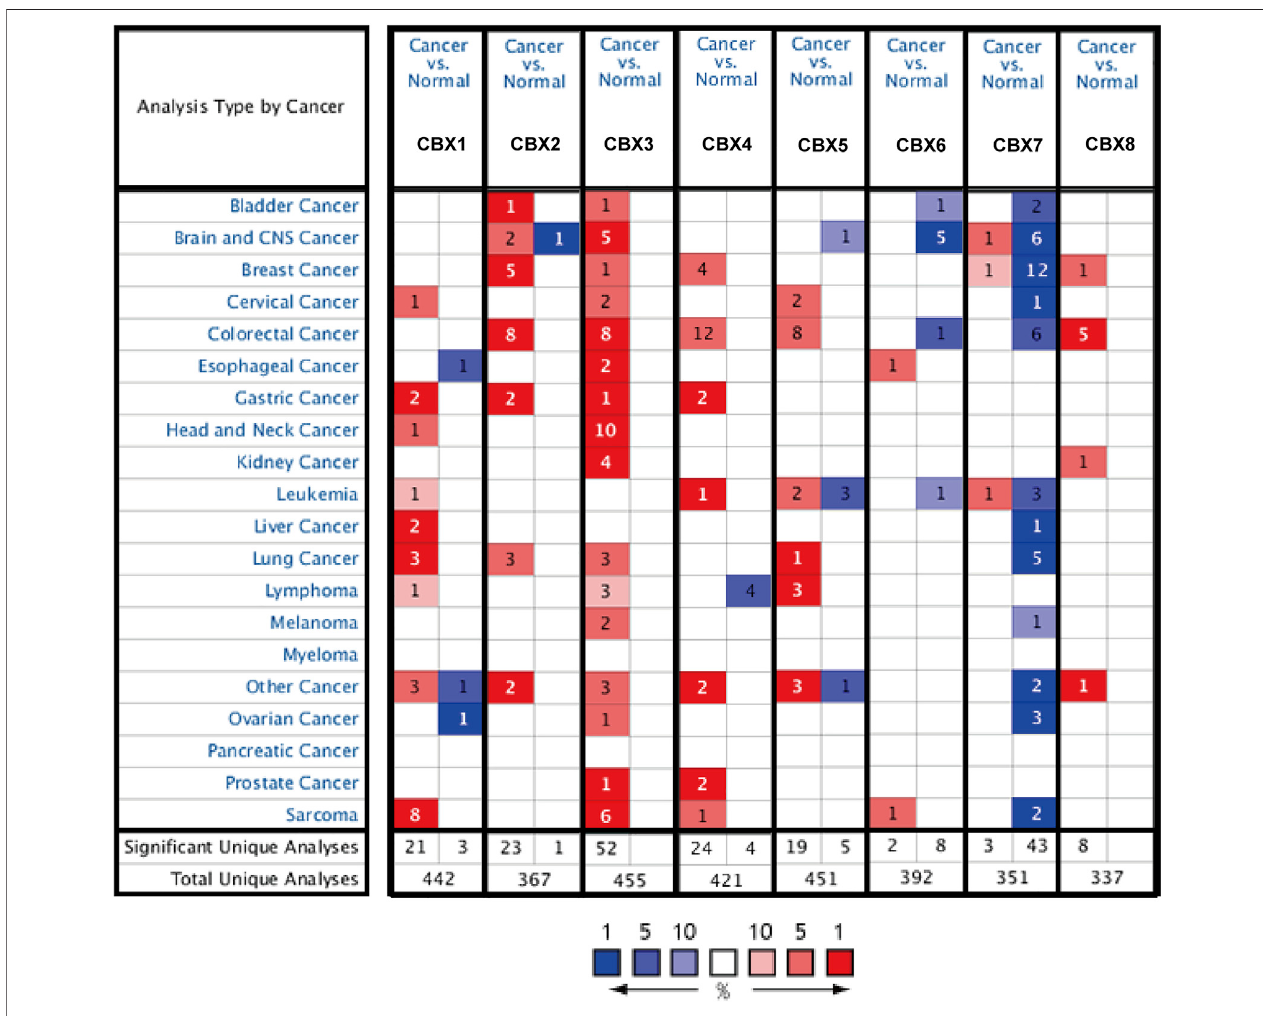
FIGURE 2 | CBX mRNA expression levels in pan-cancer. The number indicates the number of data sets validated in the Oncomine database for the differential expression of each gene. Red and blue squares indicate that gene expression is up- or downregulated,